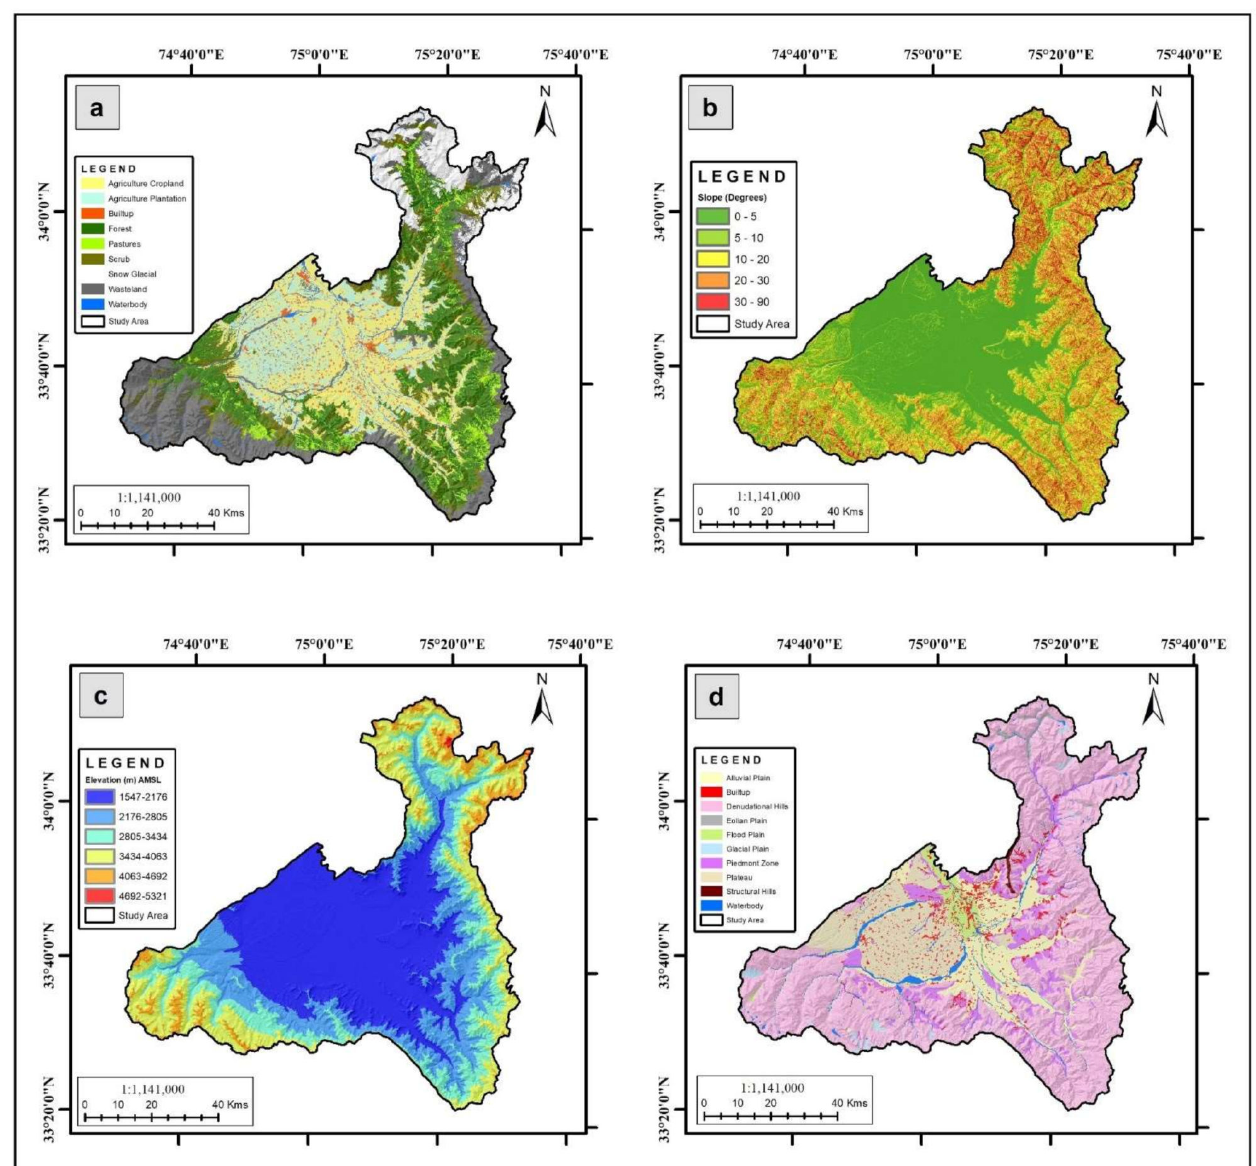
Figure 3. ( a ) LULC ( b ) Slope ( c ) Elevation, ( d ) Geomorphological classes of the study area. The slope is the rate of change of elevation for each DEM; it is the steepness of terrain [54]. The slope value may be either in degrees (values from 0–90) or the increase in percent (percentage values range from 0 to infinity). Higher slope values indicate steep terrain [55]. Slope impacts the dam’s stability since higher slopes are more vulnerable to landslides, rendering them the least suitable location for dam construction. Higher slopes are more prone to soil erosion and involve massive earthworks [58]. The following five slope range classes were used in the present study 0–5 ◦ (Flat), 5–10 ◦ (Gentle), 10–20 ◦ (Medium slope), 20–30 ◦ (Steep slopes), and 30–90 ◦ (Very Steep slopes) (Figure 3b). The overall weight of the slope parameter in the present analysis was assigned 10%. The highest scale value, 7, was assigned to the (0–5 ◦ ) slope class with high suitability for dam construction, and the lowest scale value, 1, was assigned to the (30–90 ◦ ) slope class with least suitability. A scale value of 5, 3 and 2 was assigned to (5–10 ◦ ), (10–20 ◦ ), and (20–30 ◦ ) slope classes, respectively. The slope parameter was assigned a weightage of 10% overall (Table